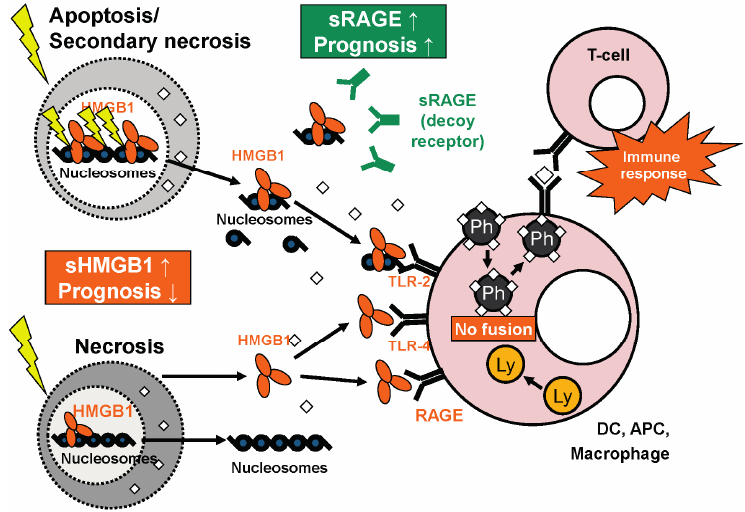
Figure 2. Overview: functions of HMGB1 and sRAGE. HMGB1 is released as single molecule during necrosis while it is set free as complex bound to nucleosomes in apoptosis/secondary necrosis. In the extracellular space, HMGB1 binds to various receptors like TLR-2, TLR-4 and RAGE on the surface of macrophages, dendritic cells (DC) and other antigen presenting cells (APC), leading to inhibited fusion of phagosomes and lysosomes within these cells. This, in turn, promotes presentation of phagocyted antigens with effective specific T-cell response. sRAGE derived from alternative splicing or proteolytic cleavage can act as a decoy receptor for HMGB1. As circulating biomarkers, high levels of HMGB1 and low levels of sRAGE correlate with poor prognosis (adapted from [103] with permission from De Gruyter).